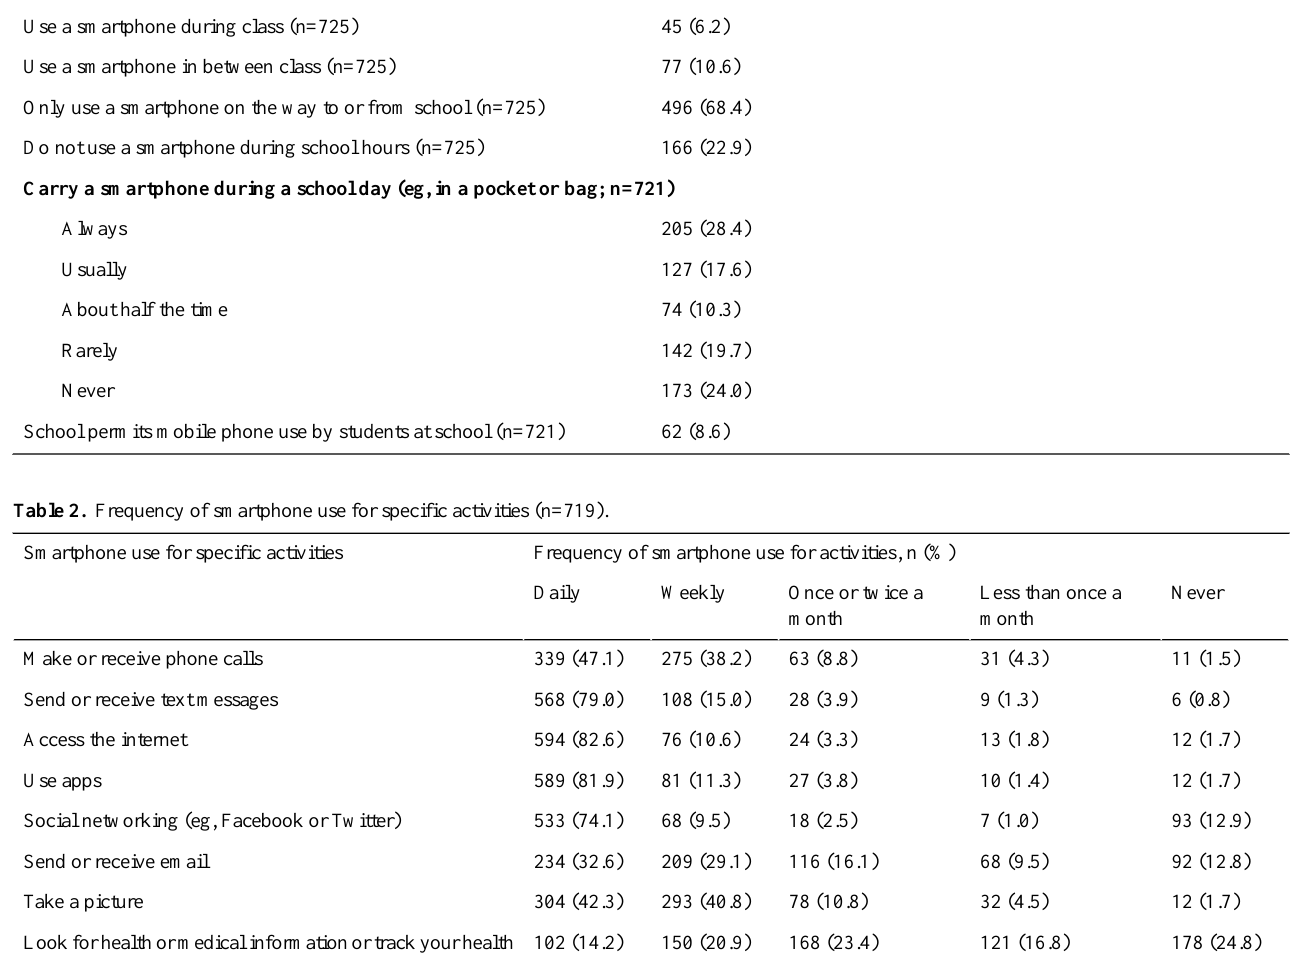
Table 1. Patterns of smartphone use among web-based survey participants who own a smartphone (N=815). Frequency of smartphone use (n=725)